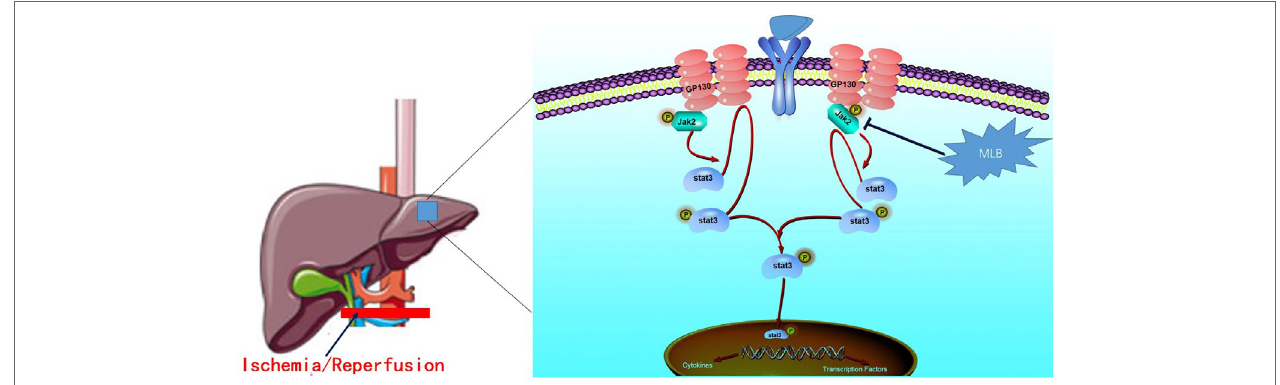
FIGURE 9 | The protective mechanism of MLB against hepatic I/R. The Jak2/Stat3 signaling pathway was activated when excessive proinflammation mediators were secreted, and then the inflammatory cytokines were further expressed. MLB could inhibit the activation of the Jak2/Stat3 signaling pathway and decrease the pro-inflammatory cytokines to reduce the hepatic I/R